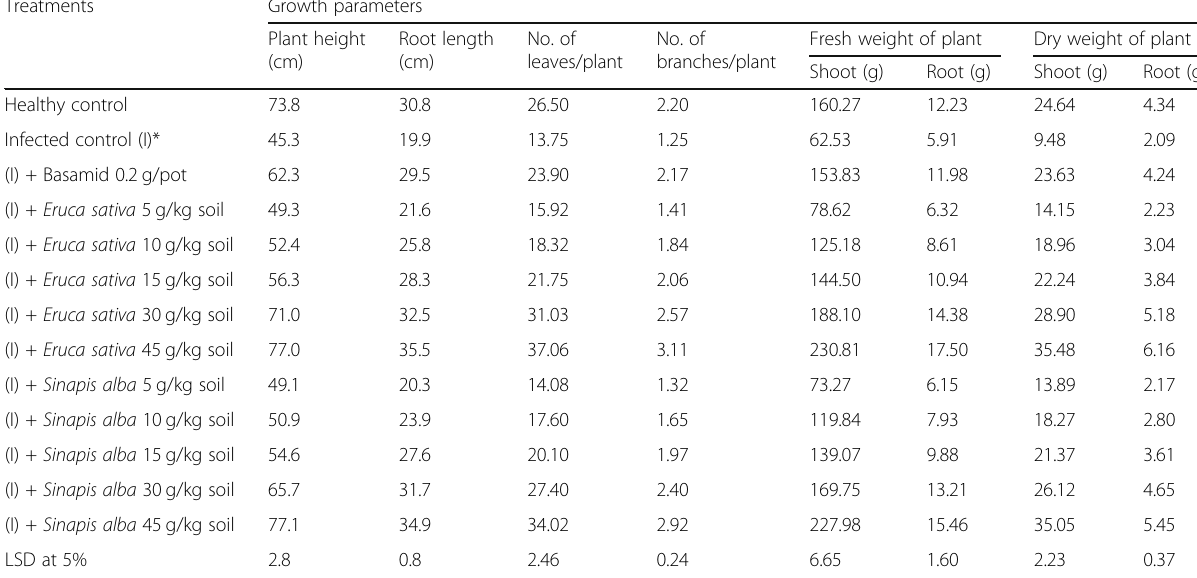
Table 3 Effect of different concentrations of both Eruca sativa L. and Sinapis alba L. seed powder and herbicide Basamid on growth parameters of Lycopersicon esculentum Mill. at 80 days from transplanting. (average of the two seasons)